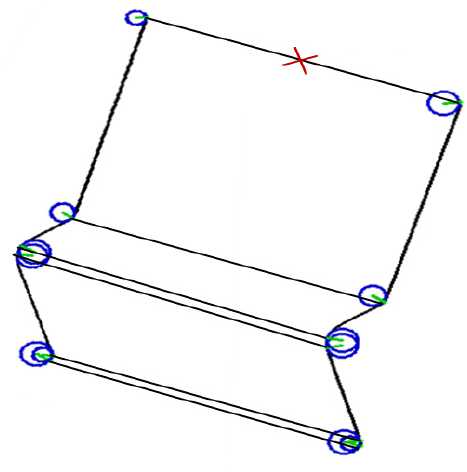
Figure 10. Schematic diagram of feature point matching.